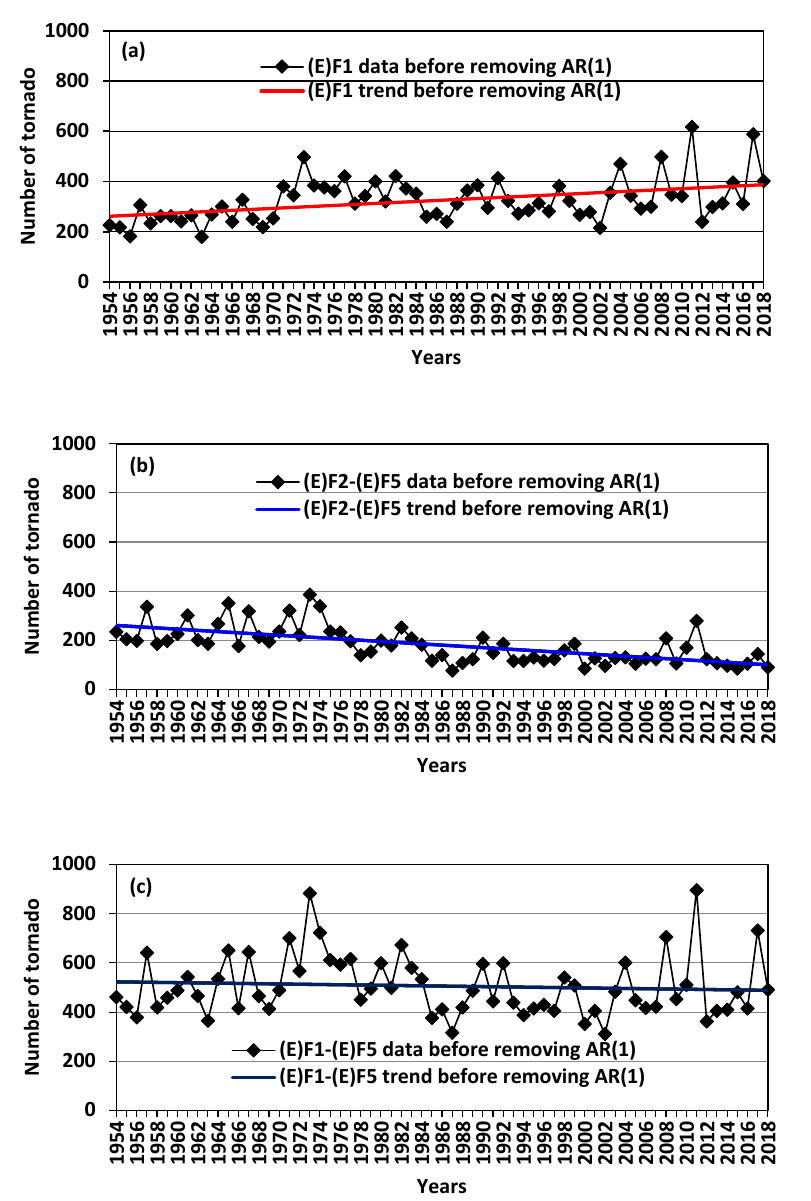
Figure 1. Time series of U.S. tornado counts (1954–2018) and its trend before removing AR(1) for ( a ) (E)F1 tornado, ( b ) sum of (E)F2 to (E)F5 tornado, and ( c ) sum of (E)F1 to (E)F5 tornado.